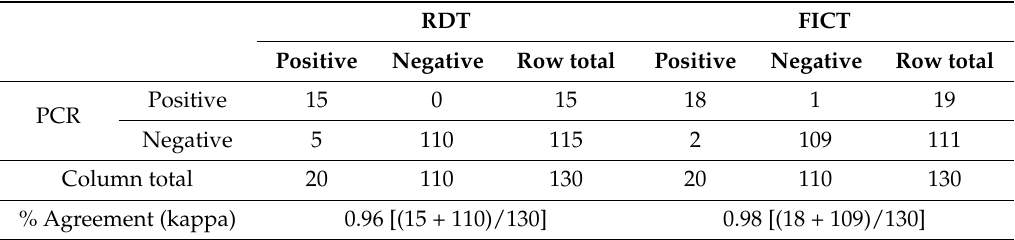
Table 2. Comparison of the clinical diagnostic performance of FICT assay with PCR and commercial